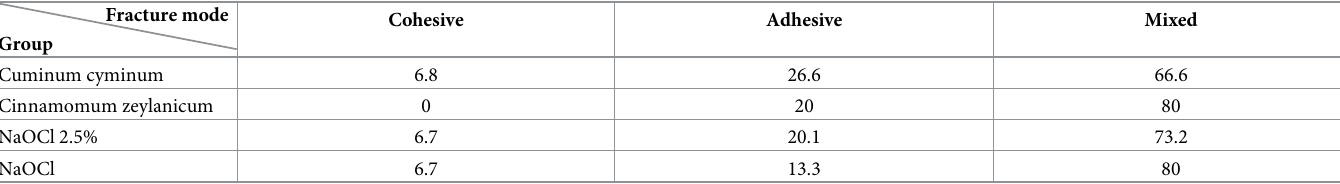
Table 3. Frequency of different types of failure modes in the groups